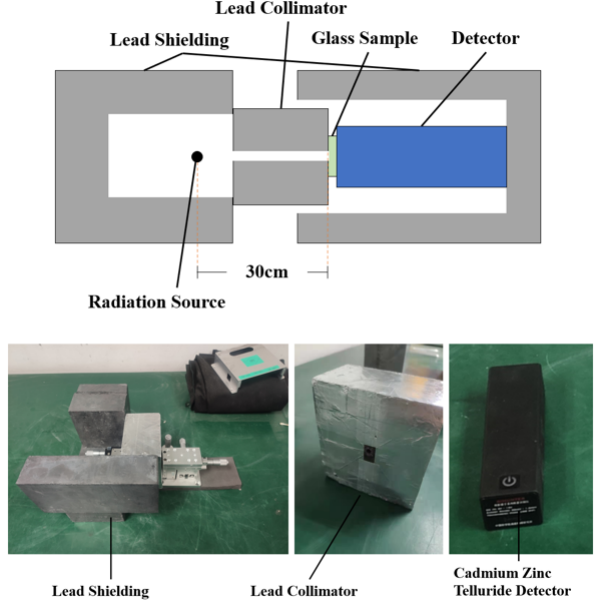
Figure 1. Structure diagram and physical diagram of the device for measuring linear attenuation coefficient with physical radiation source.